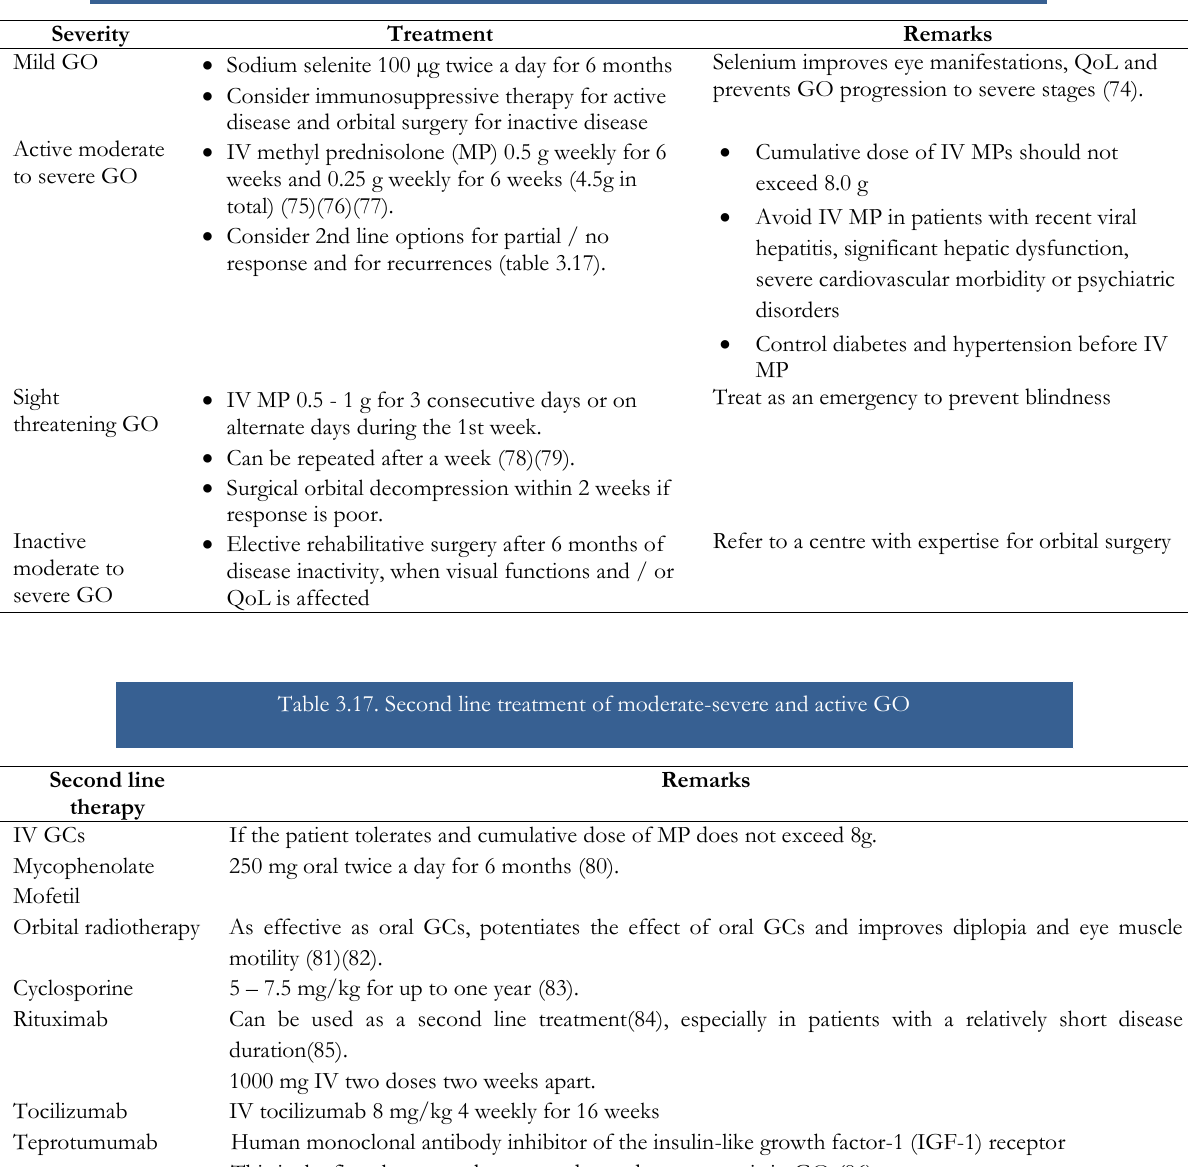
Table 3.16. Specific management of GO according to severity and activity